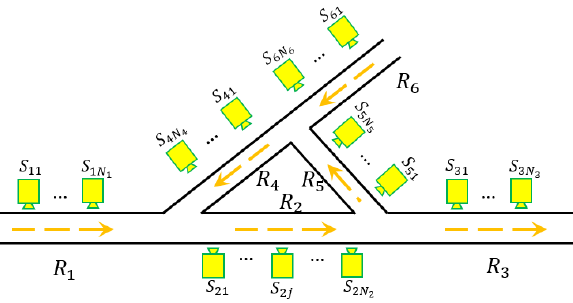
Figure 1. An example road network. R i represents the road segment. S ij represents the j th sensor on the i th road